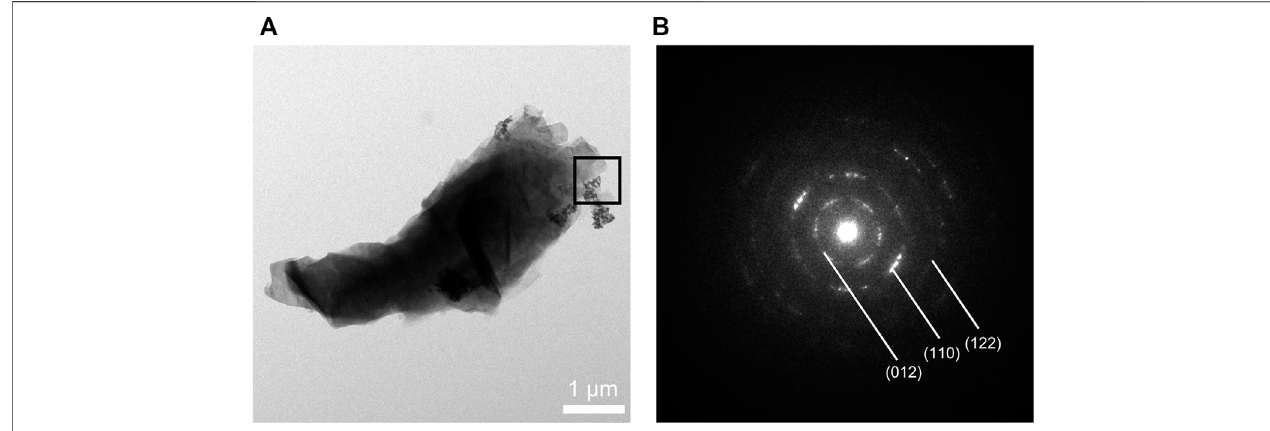
FIGURE 3 | (A) TEM photo of CaCO 3 : Eu, (B) selected area electronic diffraction pattern of CaCO 3 : Eu.